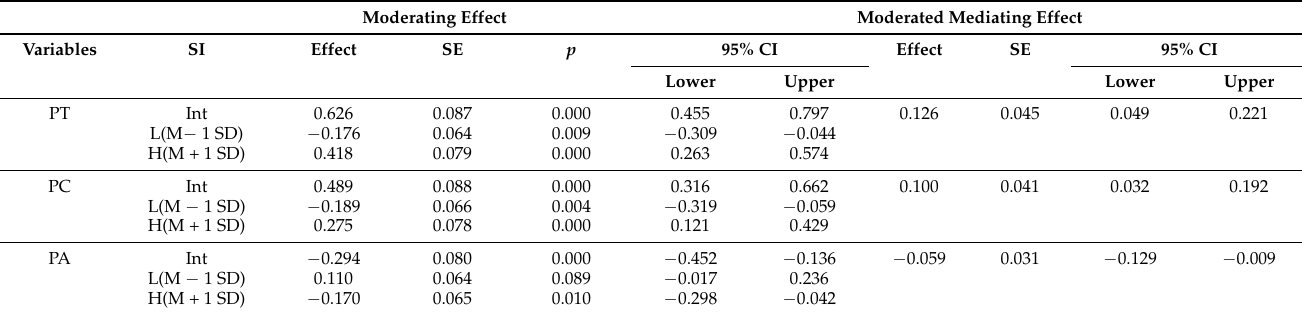
Table 3. Moderation Effect (N =